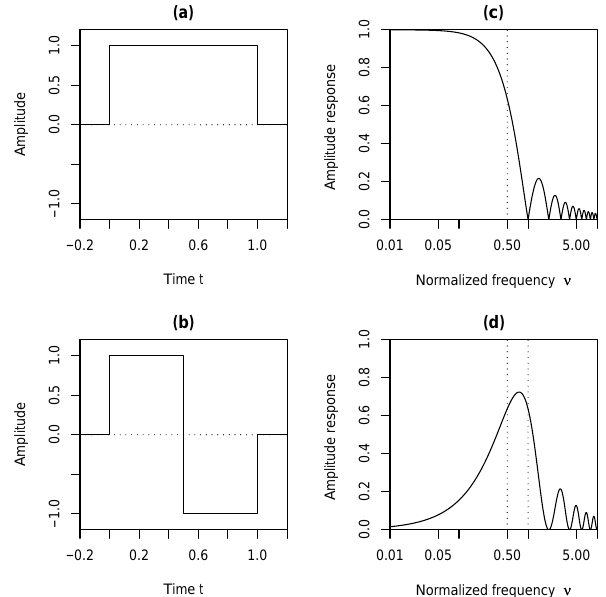
Figure 1. Time representation of the Haar (a) scaling and (b) wavelet function, and the frequency response of the associate (c) low-pass and (d) bandpass filters. Adopted from Deneke et al.